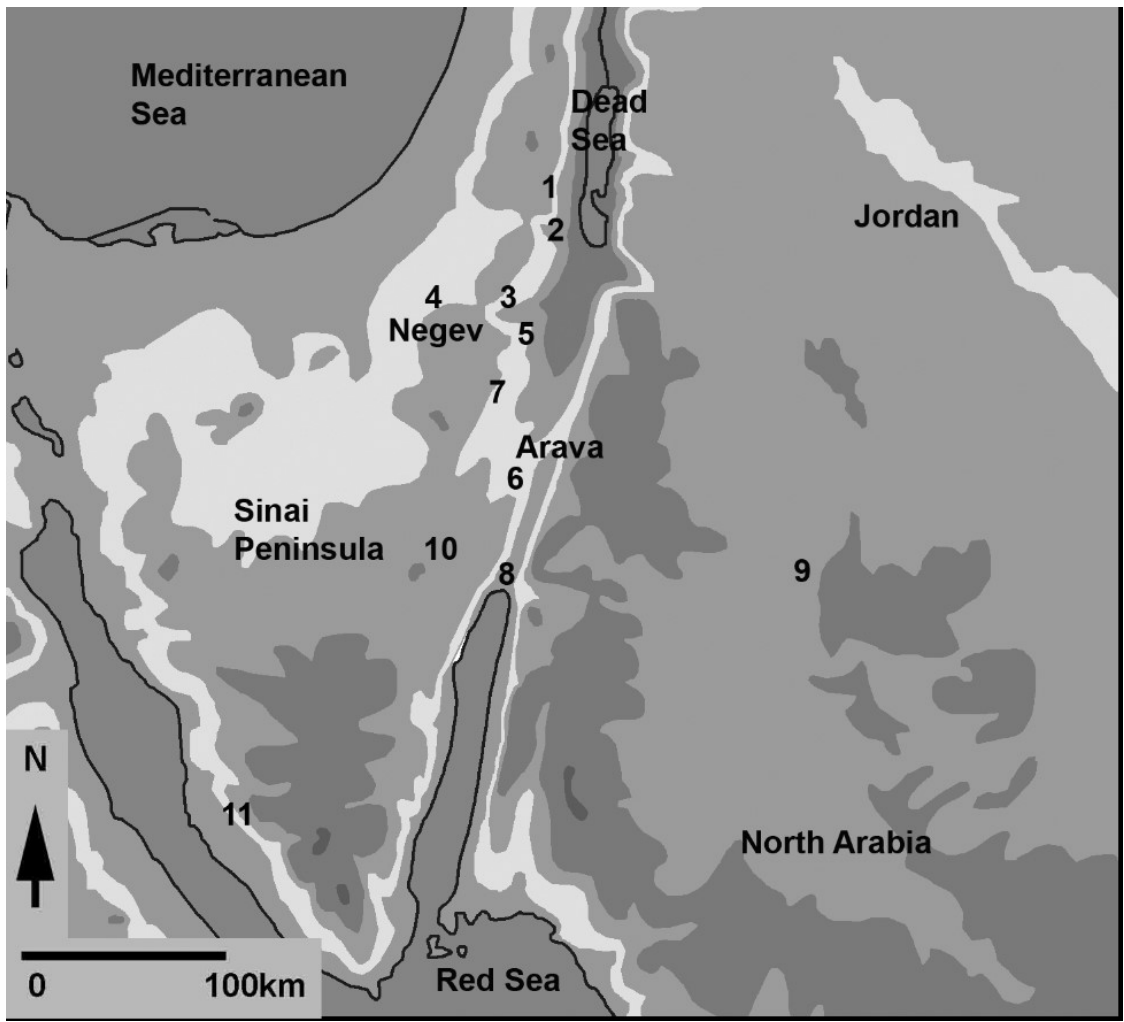
Figure 1 General location map of sites mentioned in text: 1. Arad, 2. Tamar I , 3. Ein Ziq, Har Yeruham, 4. Nahal Nizzana, Be’er Resisim, Har Tzayad, Nahal Mitnan, 5. Ramat Saharonim, 6. Biqat Uvda (Uvda Valley), 7. Har Tzuriaz and Be’er Ada, 8. Eilat, 9. al-Thulaythuwat, 10. Ath Thamad and Xasm Attarif, 11. Qaa el